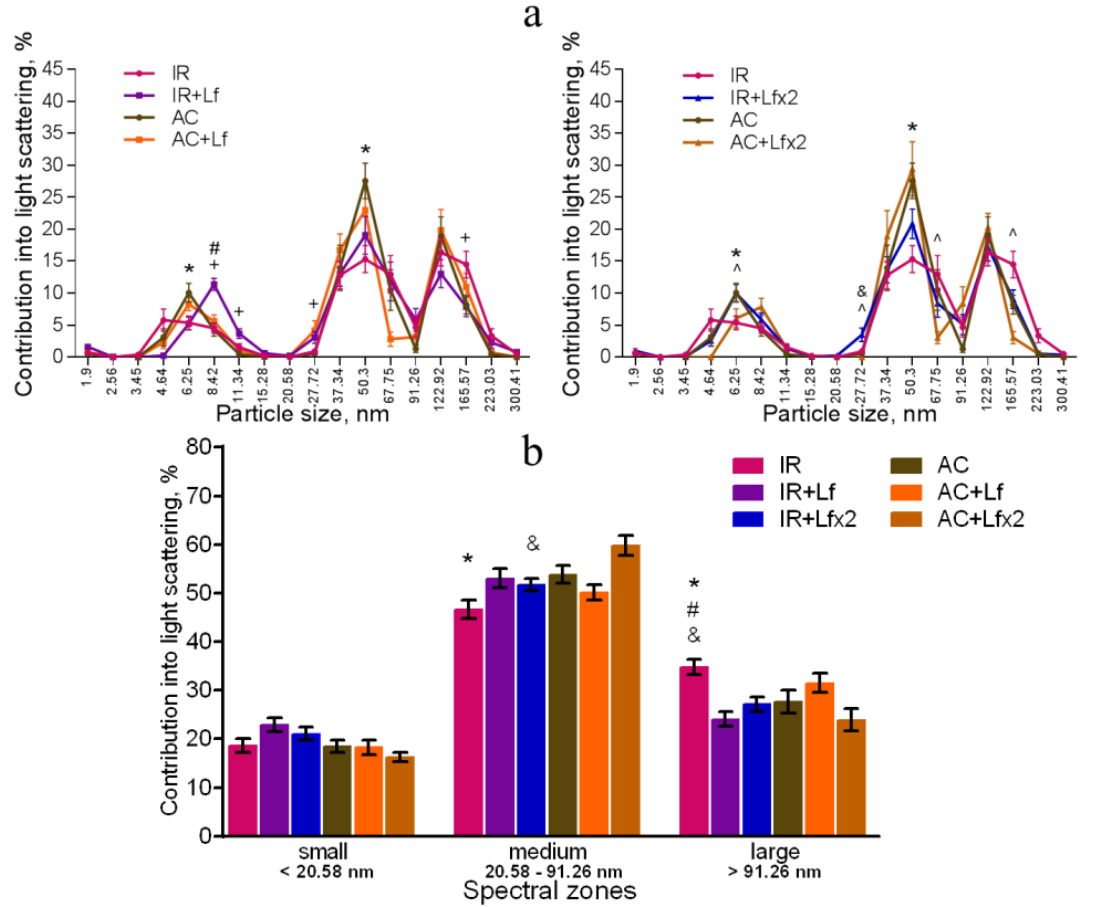
Figure 10. Effect of Lf on the changes in the DLS spectra of mouse blood serum on day 30 after 7.5 Gy gamma irradiation. Lf (i.p.; 4 mg/mouse) was administered immediately after irradiation/sham-irradiation (IR+Lf, IR+Lf × 2, AC+Lf, AC+Lf × 2) and 24 h after it (IR+Lf × 2, AC+Lf × 2). Particle size distribution ( a ). Particles distribution by spectral zones ( b ). n = 9–15 for each group. * p < 0.05—IR vs. AC, # p < 0.05—IR+Lf vs. AC+Lf, & p < 0.05—IR+Lf × 2 vs. AC+Lf × 2, + p < 0.05—IR vs. IR+Lf, ^ p < 0.05—IR vs. IR+Lf×2.